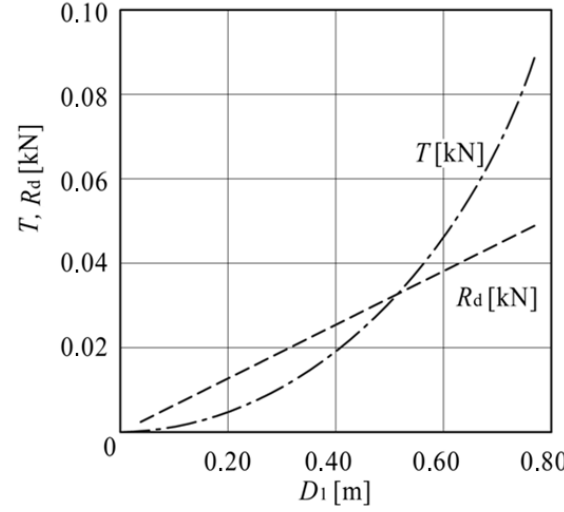
Figure 3. The dependence of the components of the tractive resistance of the slotting disk on the diameter It has been established that with an increase in the